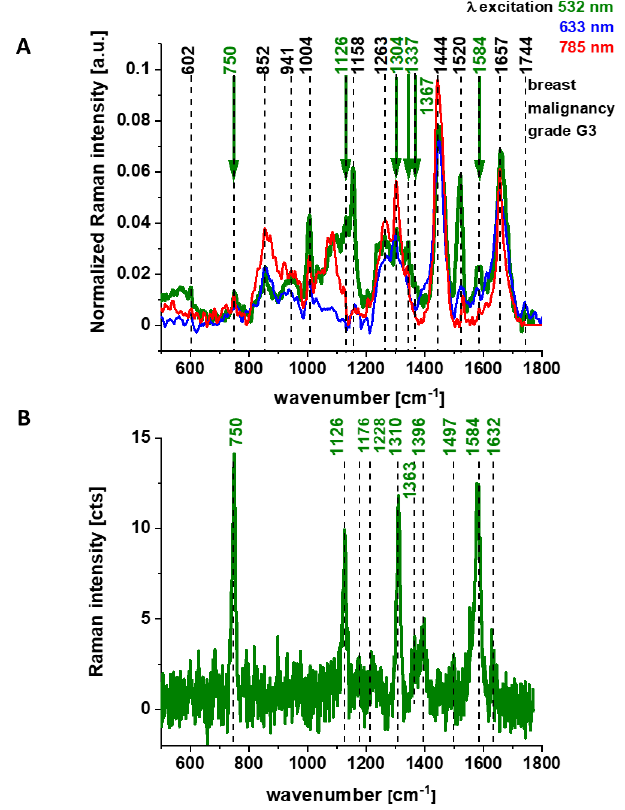
Figure 2. The average Raman spectra of the ex vivo human breast cancer tissue surgically resected specimens, ductal cancer, grade of malignancy WHO G3 at the excitations 633 nm ▬ (blue), 532 nm ▬ (green) and 785 nm ▬ (red) (number of patients n = 5, for each patient thousands of Raman spectra obtained from cluster analysis) ( A ), Raman spectrum of the pure cytochrome c at 532 nm excitation ( B ).